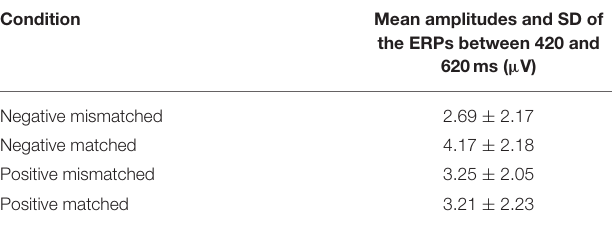
TABLE 1 | Descriptive statistics for ERP data.